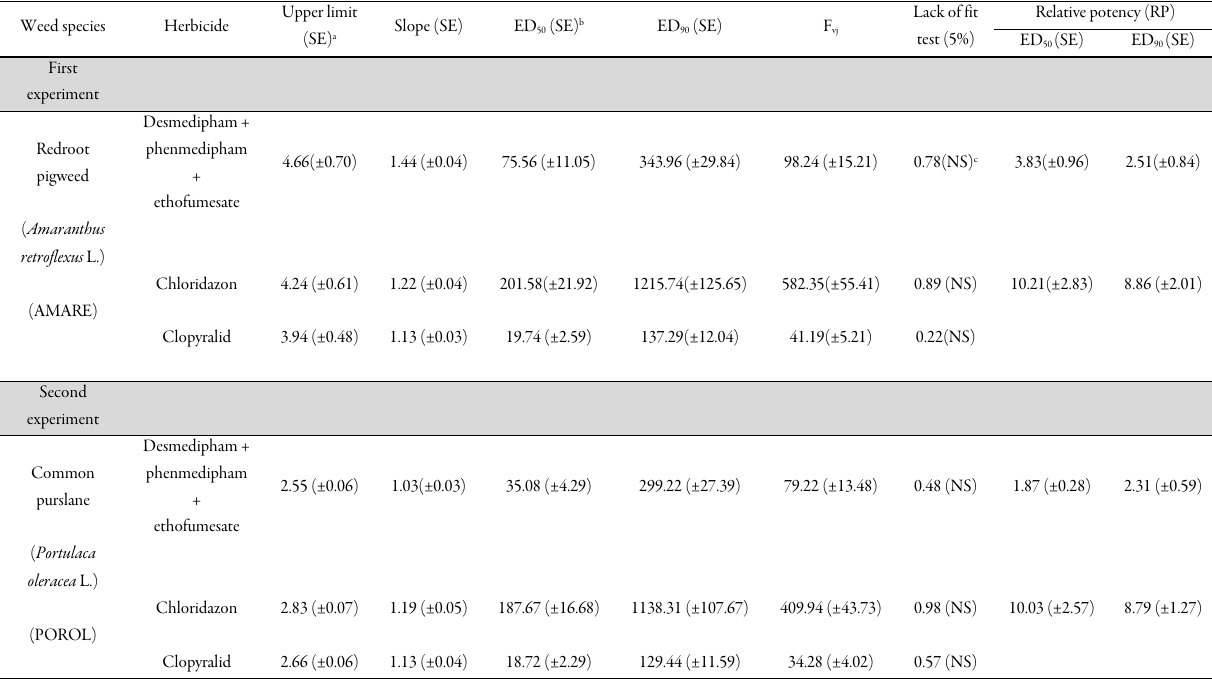
Table 1. Summary of dose–response analysis of dry matter at 21 days after treatment (DAT) (four to six true leaf stage) for both of experiments. In both experiments the test for lack of fit were not significant, indicating that the logistic model was able to describe the data better than an ordinary ANOVA